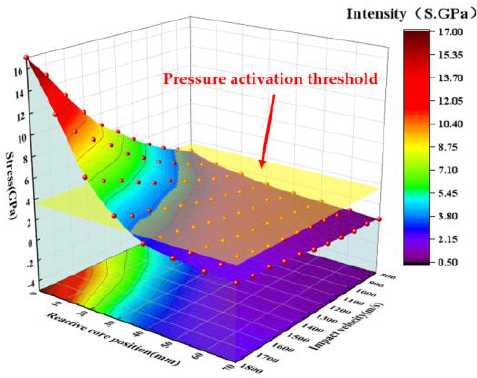
Figure 7. Changes in internal stress at different impact velocities(red ball: peak internal stress of the reactive core).